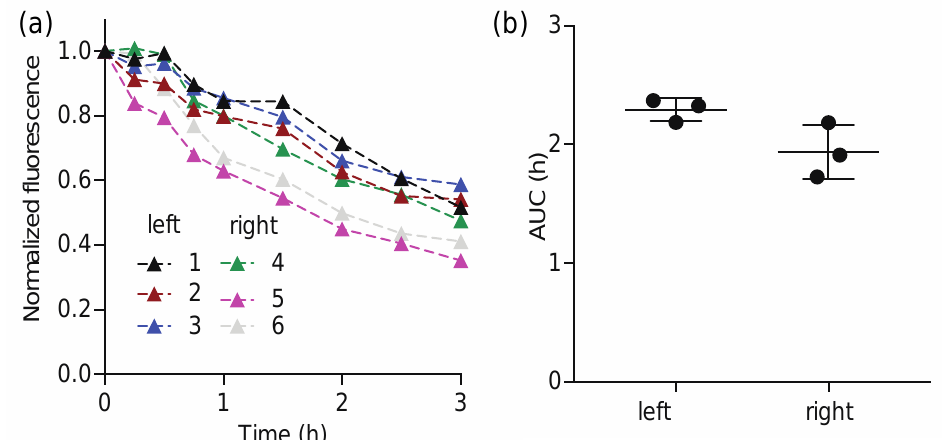
Figure 3. Lymphatic clearance measured by the LymphMeter 1.0 in the skin of the pig’s flank after bolus intradermal administration of 50 µL of ICG (0.0025 mg/mL) in a solution of 5% HSA, using MicronJet600 TM microneedles. ( a ) Normalized fluorescence signal at each injection site over time on the left and right side. ( b ) AUCs of ICG clearance curves from left and right flank. Data shown as mean ±S.D. and analyzed by paired Student’s t -test; p > 0.05.